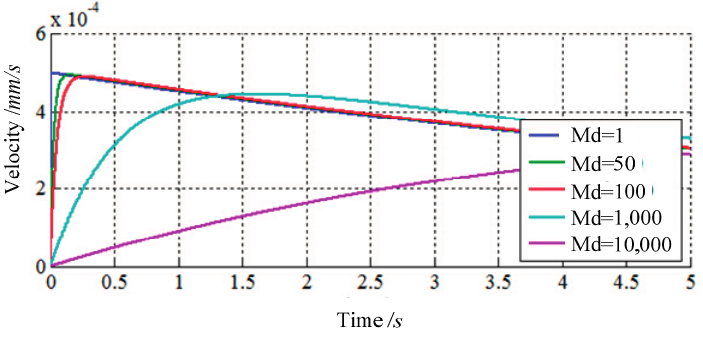
Figure 4. The responses of impedance control compensator with changing M d .